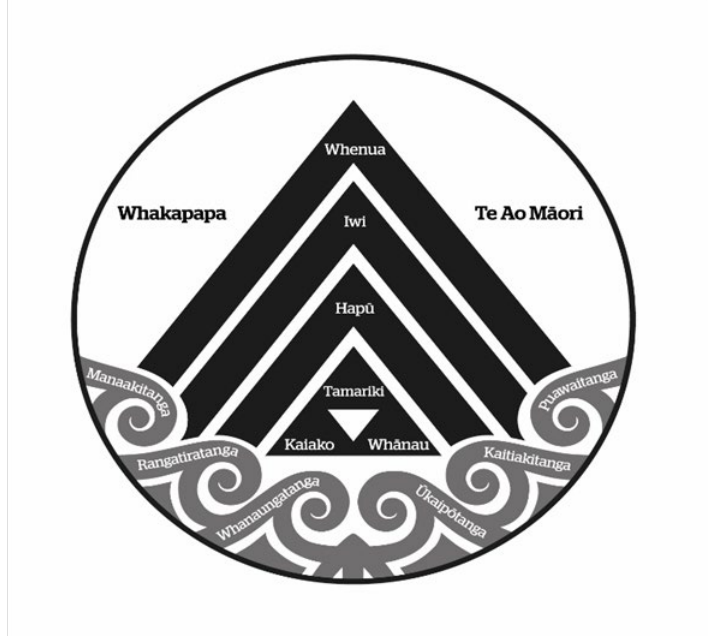
Figure 1. Whenua papatipu-oranga tonutanga (sustenance of ancestral